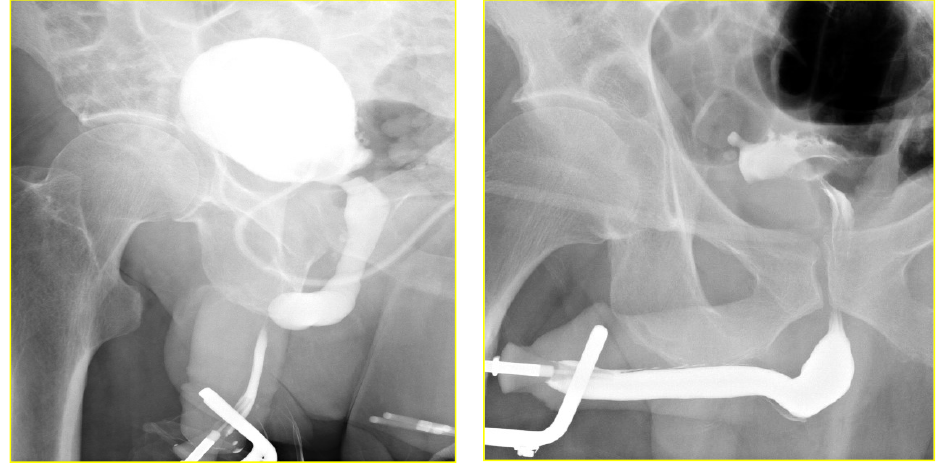
Figure 5. Retrograde urethrogram in a patient with 0.8 cm stricture pre and 24-h post double-layer continuous running suture re-anastomosis.